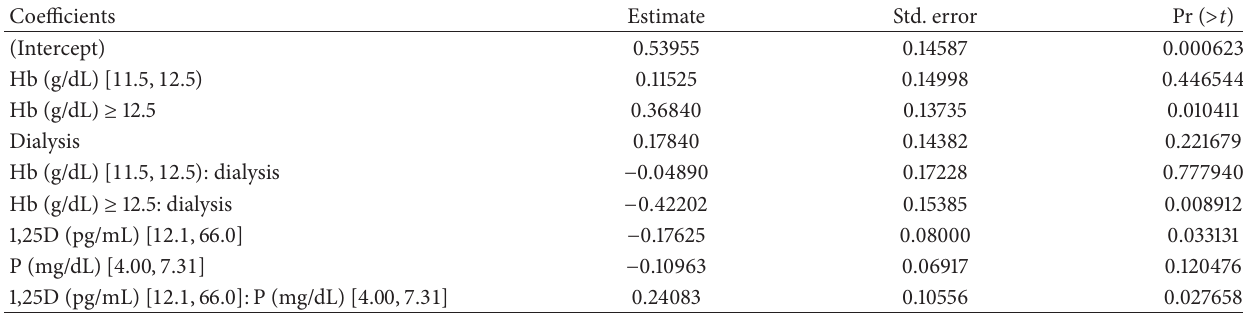
Table 6: Adjusted association between RVV and dialysis in CKD patients.